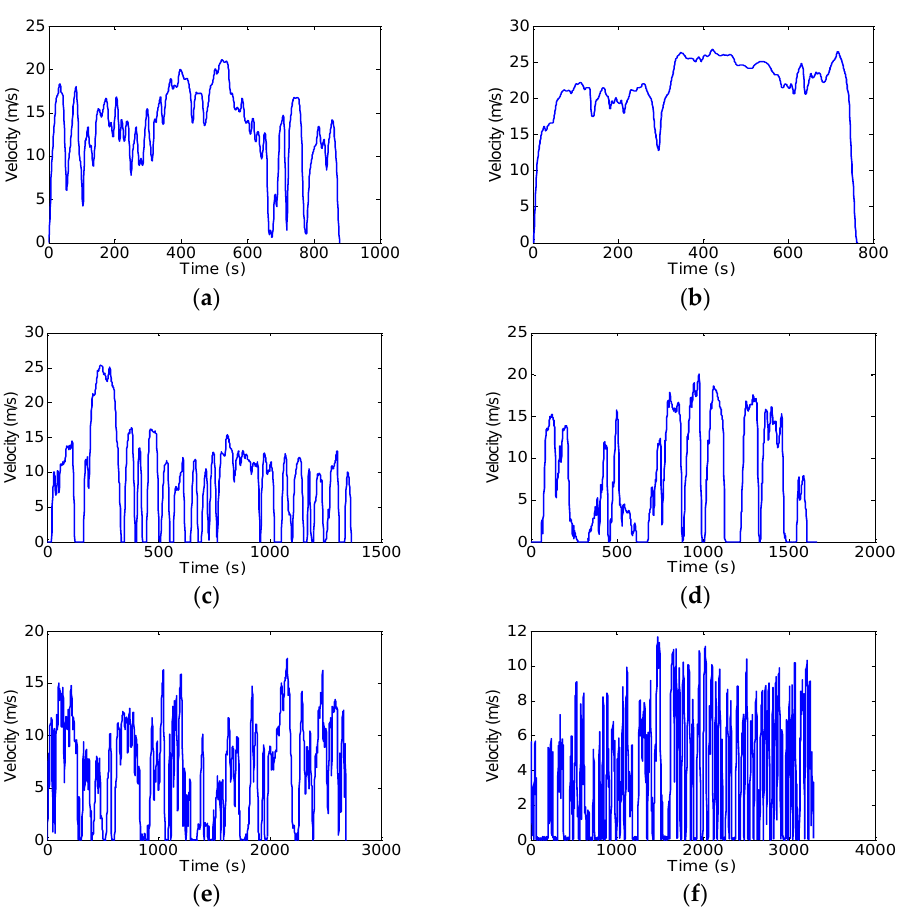
Figure 9. Six standard driving cycles. ( a ) is the INDIA_HWY_SAMPLE driving cycle; ( b ) is the HWFET driving cycle; ( c ) is the UDDS driving cycle; ( d ) is the WVUSUB driving cycle; ( e ) is the INDIA_URBAN_SAMPLE driving cycle; ( f ) is the UKBUS6 driving cycle.